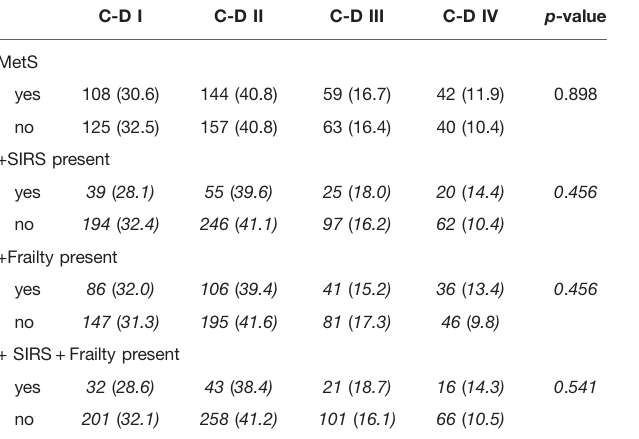
TABLE 5 | Analysis of the impact of MetS on morbidity and mortality adjusted for BMI class, SIRS, and